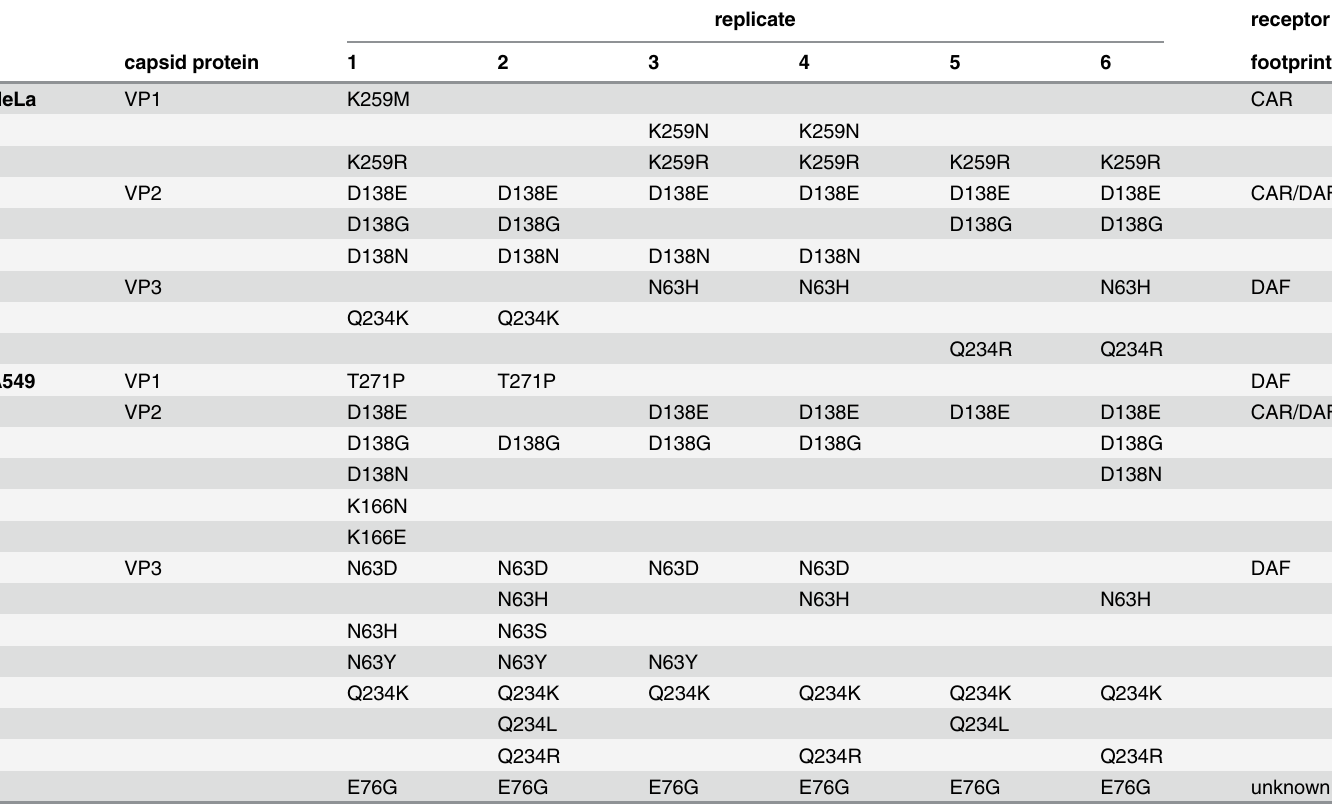
The amino acid changes for each variant are listed according to capsid protein (VP1, VP2 or VP3), and their involvement in interacting with either or both receptors is indicated (receptor